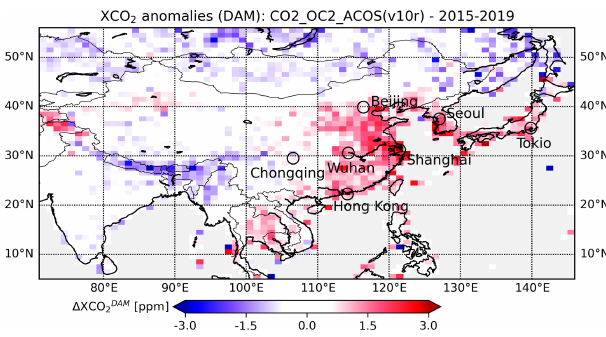
Figure 4. As Fig. 3 but for China and surrounding